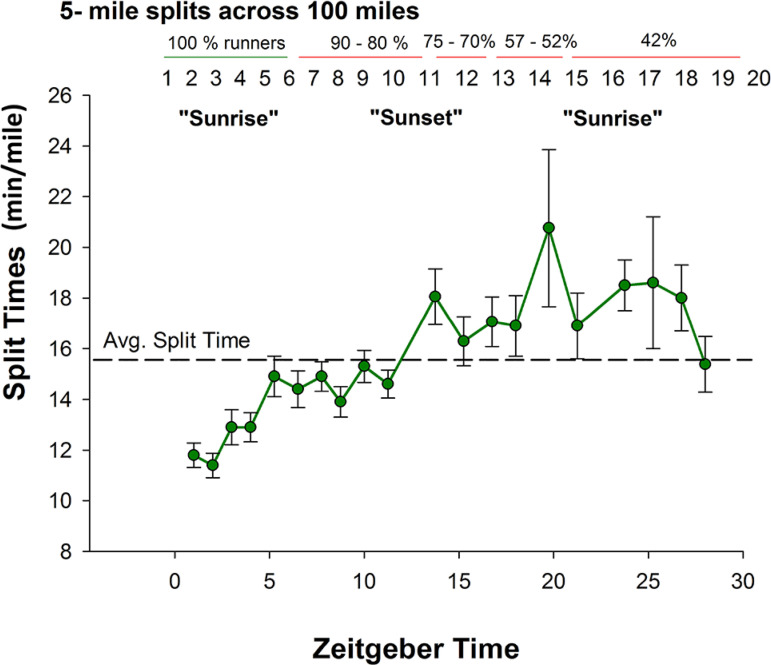
In order to dissect time-dependent patterns of human endurance capabilities under total sleep deprivation/sleep loss, running pace [green] was quantified every 5 miles of a 100-mile ultramarathon held in the spring (Amelia Island, FL; n=21, to start). Sample size across the race was dependent on dropout rate [upper X-axis, percentages; 100% [green]; < 100% [red]). Pace was under homeostatic influence for the first 50 miles and circadian influence from 50 - 100 miles. Race splits were plotted in Zeitgeber time (ZT; ZT 0/ZT 24, sunrise [~0730]; ZT 12, sunset [~1930]). The race started near sunrise (ZT 0/24). Average race pace was 15.1 + 2.3 min/mile. Average race finish time was 25.2 + 3.8h with continuous running efforts across the night (ZT 12 - ZT 24).